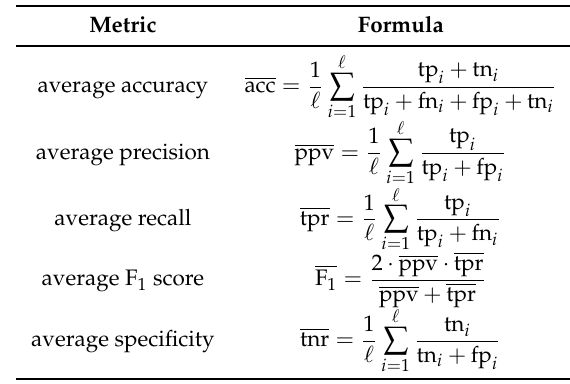
Table 3. Metrics for the evaluation of multiclass classification problems, where (cid:96) is the number of